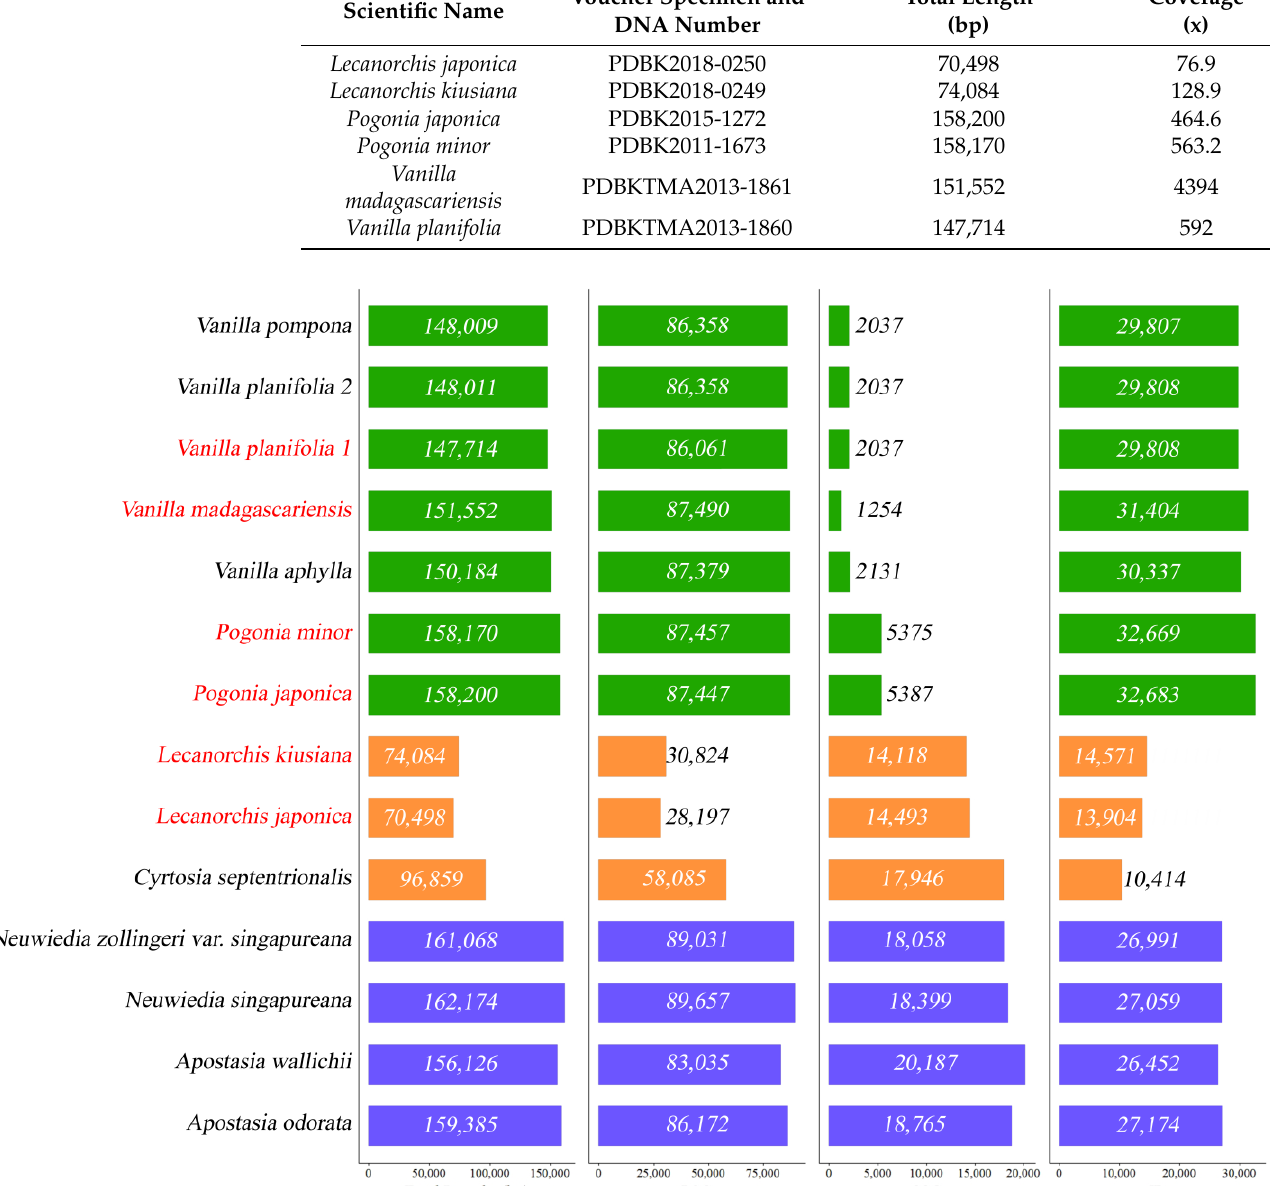
Figure 1 . Plastome size variation among 14 species of Vanilloideae and Apostasioideae. The red scientific names indicate newly decoded plastomes. Green bars indicate the photosynthetic species, and orange bars indicate the mycoheterotrophic species. Blue bars indicate the four Apostasioideae species.